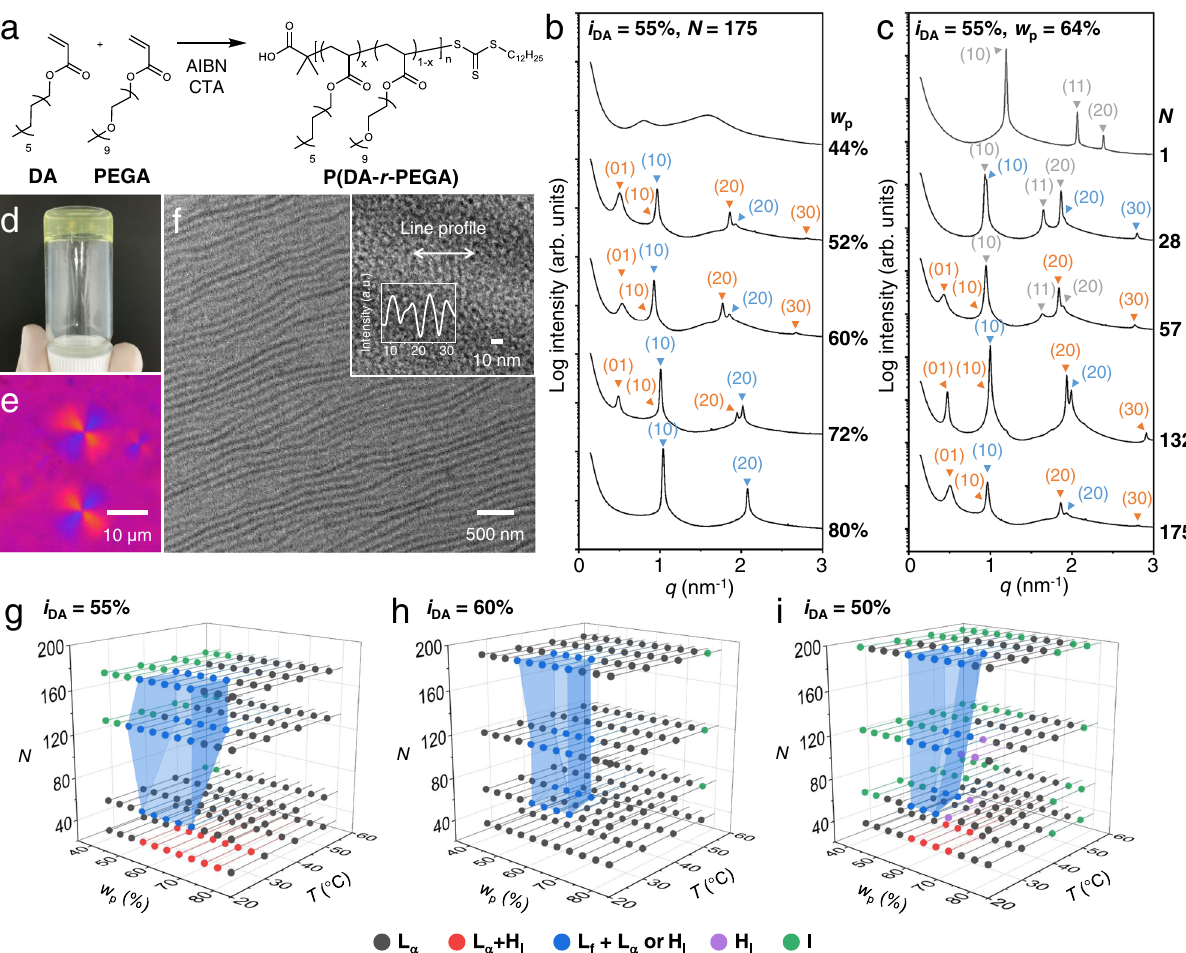
Fig. 2 Phase behavior of the amphiphilic random copolymer in water. a Synthetic route to P(DA- r -PEGA) by RAFT copolymerization. b SAXS data of P(DA 96 - r -PEGA 75 ) as a function of polymer weight fraction ( w p ). The data obtained at room temperature are plotted. Peak positions marked with orange and blue triangles are assigned to the structure factors from the bilayer-folded lamellae and the unfolded lamellae. c SAXS data of P(DA- r -PEGA)s with i = 55% and different N . Concentration is fi xed at 64 wt%. The SAXS pattern of C12E9 is also shown as a reference at N = 1. Peak positions marked with DA gray triangles are assigned to the structure factors from the hexagonal geometry. d Photo of 64 wt% aqueous solution of P(DA 73 - r -PEGA 59 ) at room temperature showing the gel state. Yellow color comes from the trithiocarbonate moiety included at the chain end. e Polarized optical micrograph of spherulites obtained upon slow cooling (0.5 °C/min) of the 64 wt% solution of P(DA 73 - r -PEGA 59 ) from the isotropic state at 55 °C. f Cross-sectional TEM image of the vitri fi ed solution of P(DA 73 - r -PEGA 59 ) at 60 wt% concentration. The solution contained 5 wt% of sodium silicate and 0.2 M HCl. The microtomed fi lm was further stained with RuO 4 . g – i Phase diagrams for the polymers with i DA = 55% ( g ), 60% ( h ), and 50% ( i ) as a function of w p , N , and temperature ( T ). The following phases were identi fi ed by SAXS analysis: L α ( fl uidic multilamellar, gray); H I (hexagonal, violet); L α + H I (red); L f (bilayer- folded lamellar) + L α or H I (blue); I (isotropic, green). Blue shade indicates the phase boundary for the L f + L α or H I